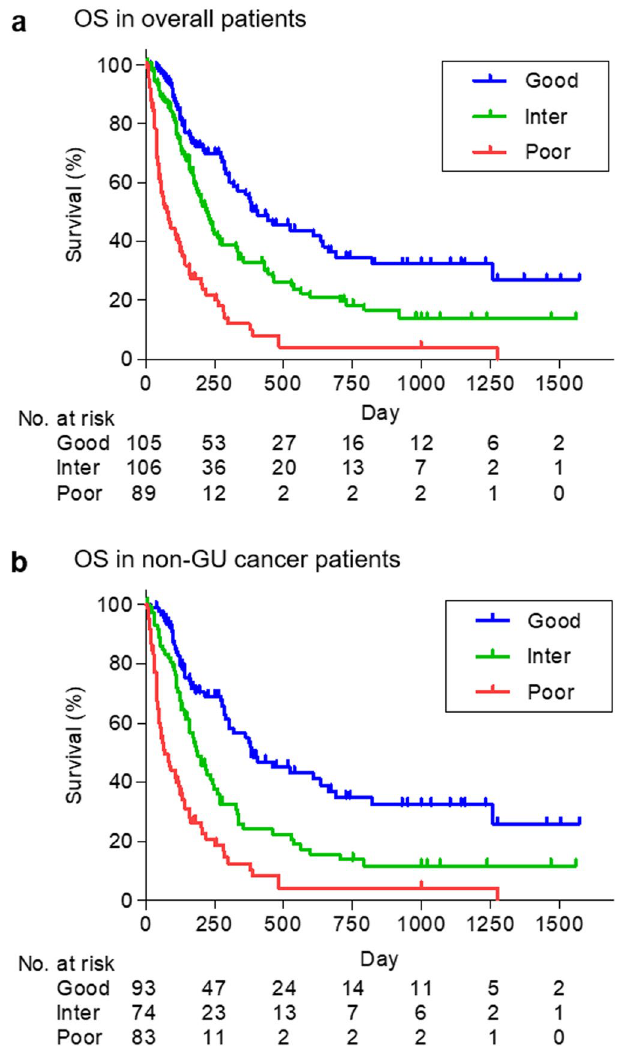
Figure 2. Overall survival of risk groups according to PLaCT risk classification. ( a ) Overall survival (OS) in overall patients ( P < 0.0001). ( b ) OS in non-genitourinary (GU) cancer patients ( P < 0.0001). Inter, intermediate. Statistical analyses were performed using GraphPad Prism 5 (https ://www.graph